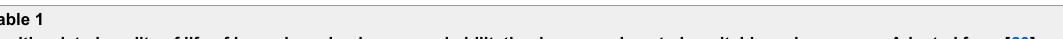
Table 1 Health-related quality of life of home-based pulmonary rehabilitation in comparison to hospital-based programs. Adapted from [29]. Study HRQL